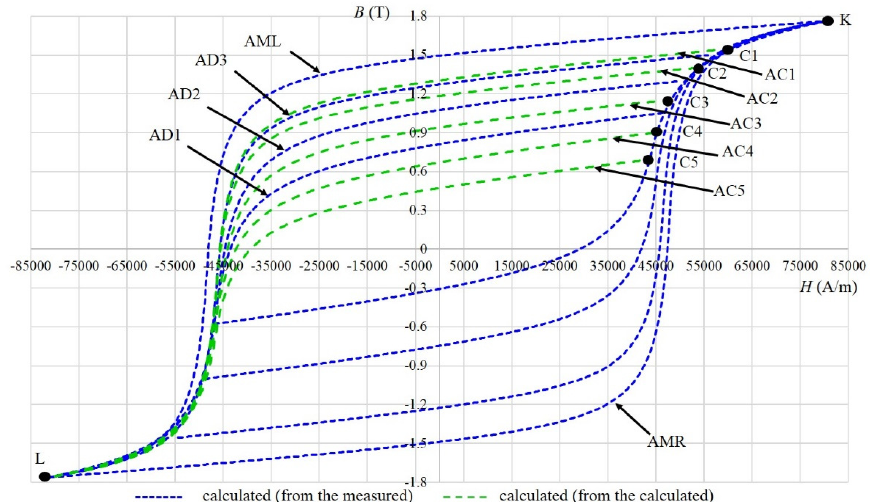
Figure 13. Calculated curves based on the measured curves (AML, AMR, AD1–AD3, AI1–AI3), and calculated curves in the area between the measured curves AC1–AC5. The parameters of the calculated curves AC1–AC5, together with used points and the nearest curve obtained based on the measured curve, which was the basis for the curve calculation, are presented in Table 24. Table 24. Parameters of the calculated curves AC1–AC5. Basis Curve Points and Parameters